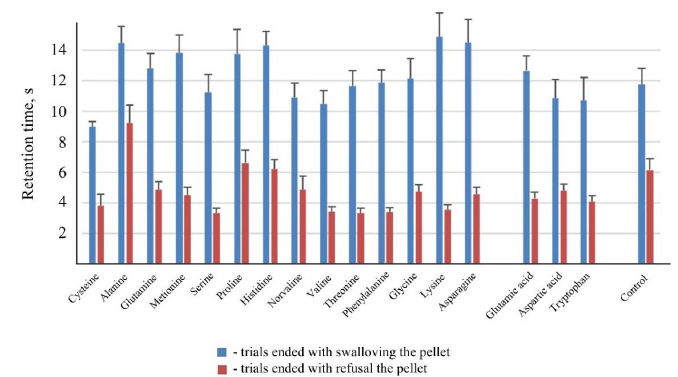
Figure 9. Retention time after the first grasp of pellets flavored with amino acids, ended with swallowing or refusal of the pellet by barramundi Lates calcarifer . Differences between trials completed with each amino acid are significant at p < 0.001 for all substances (Mann–Whitney U-test). Whiskers are the s.e.m. J. Mar. Sci. Eng. 2022 , 10 , x FOR PEER REVIEW